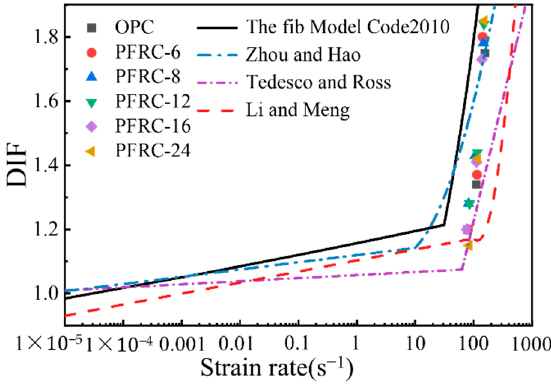
Figure 10. DIF for dynamic compressive strength of OPC and PFRC.